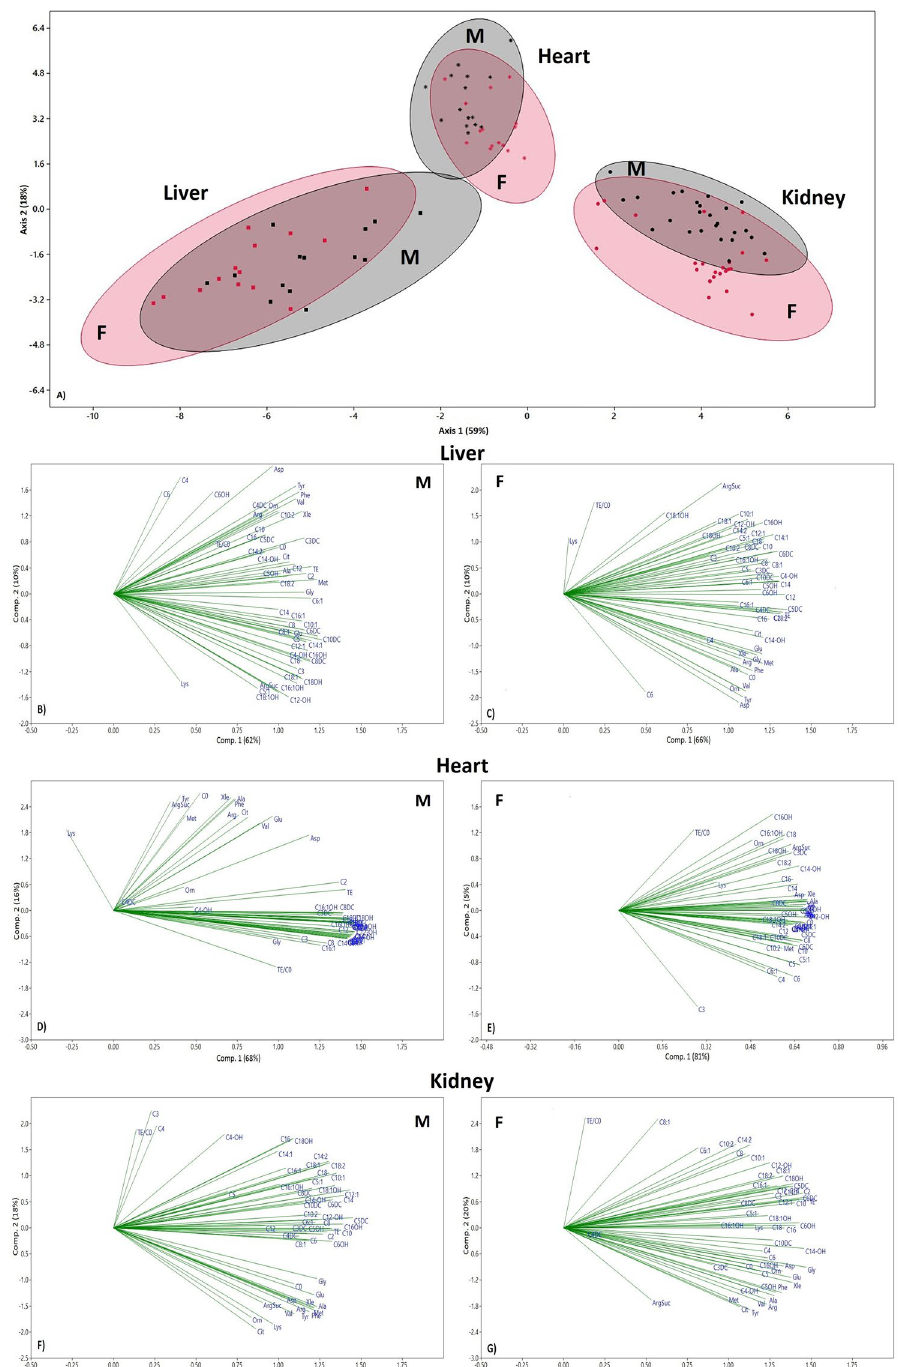
Figure 7. LDA score plot of all molecules (Panel A) and PCA of all molecules stratified according to sex and organ (panel B–F). Panel A, black and the red colours indicate male and female samples, respectively. Plotted ellipses estimate a region where 95% of population points are expected to fall. Panels B and C represent PCA loading plots in male and female liver samples; Panels D and E represent PCA loading plots in male and female heart samples; and Panels F and G represent PCA loading plots in male and female kidney